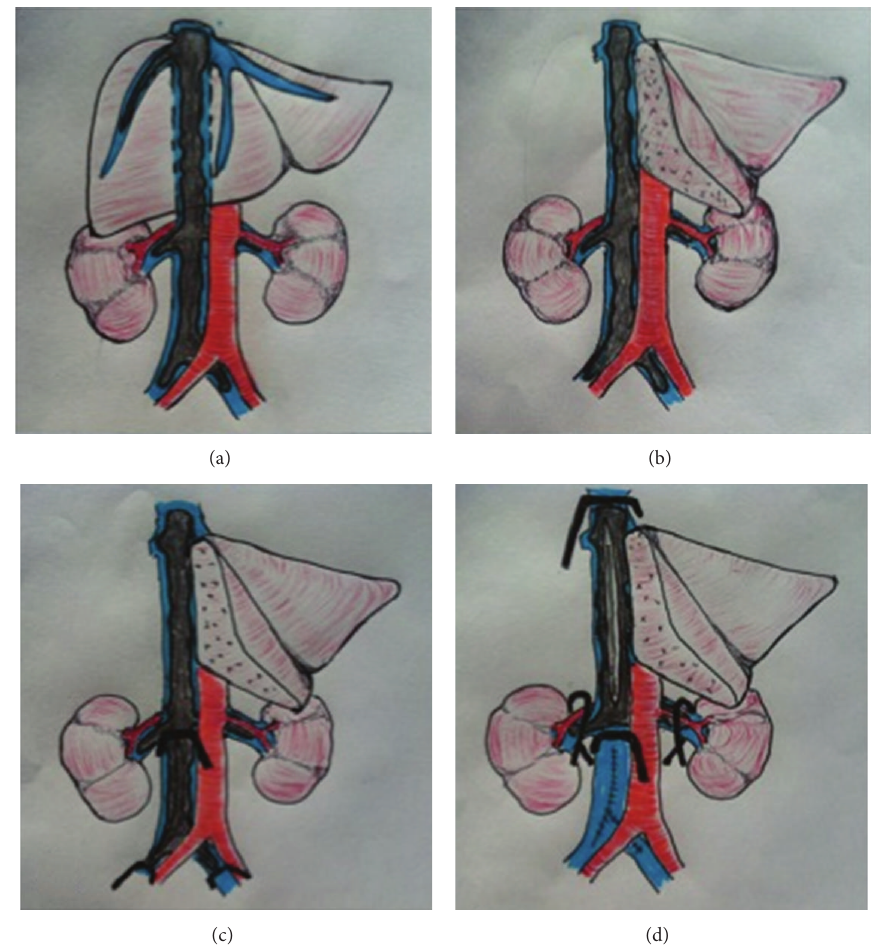
Figure 3: Schematic illustration demonstrating (a) IVC exposure and the extent of the tumour thrombus prior to resection. (b) Retrohepatic VC exposure via a right hepatectomy. (c) Infrarenal VC occlusion, enabling cavotomy and thrombus extraction. (d) Suprarenal VC occlusion, enabling cavotomy and thrombus